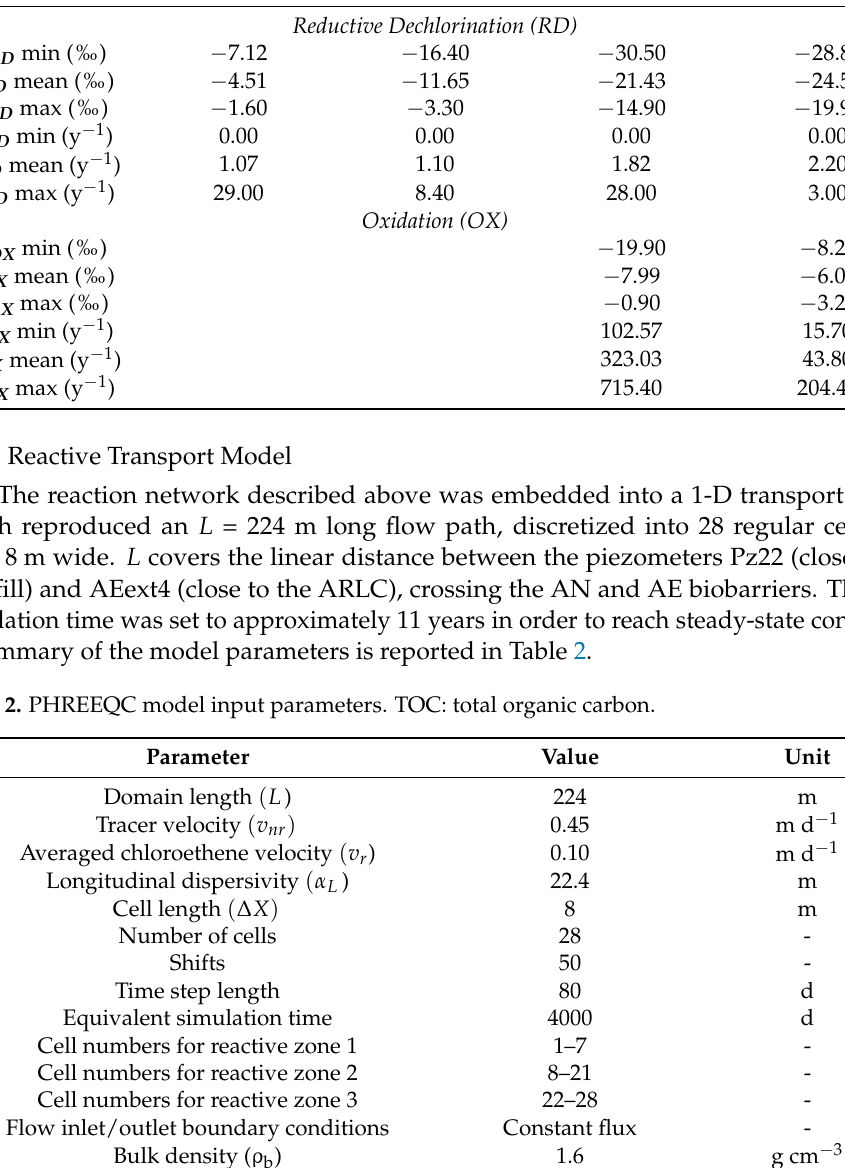
Table 1. Statistics of the enrichment factors ( ε ) and first-order degradation constants ( k ) obtained through a literature review. All ε values are expressed as “per mille” (‰). PCE